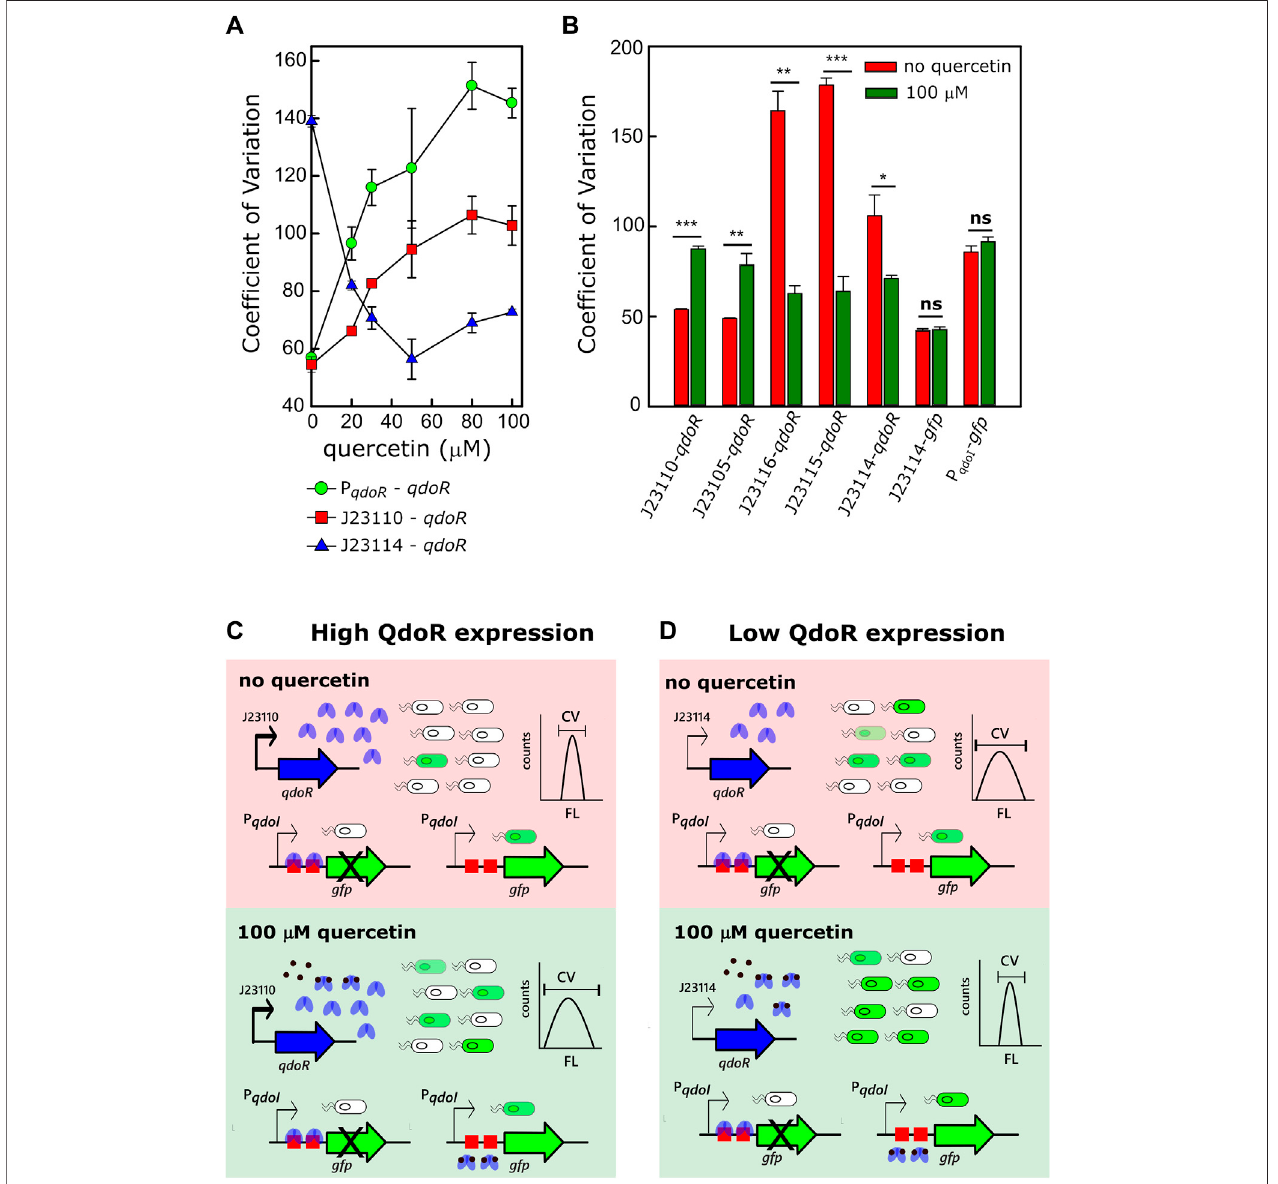
FIGURE3| TheQdoRexpression levelaffectstheamountofnoiseuponquercetin induction. (A) Thecoef fi cient ofvariation(CV)wascalculatedfromtheFLvalues measuredby fl owcytometry( λ ex (cid:2) 488 nm, λ em (cid:2) 530 nm).Threecircuitscontrolling gfp expressionwereinducedwithincreasingquercetinconcentrations:P qdoR - qdoR ( qdoR expression controlled by the minimal qdoR promoter) and J23110- qdoR and J23114- qdoR ( qdoR is expressed constitutively by the J23110 and J23114 promoters, respectively). The experiment was conducted with biological triplicates. (B) The CV of GFP expression in uninduced and induced E. coli cultures was correlatedwiththecircuitsdepictedin Figure2A ;allthesecircuitshad gfp asareporter.TheJ23114- gfp constructhastheJ23114constitutivepromotercontrollingthe expressionof gfp .TheP qdoI - gfp constructhasthenon-repressed qdoI promotercontrolling gfp expression.NotethatbothcircuitswithoutQdoRrepressiondonothave considerable variations on CV values upon the addition of quercetin. (C, D) Illustrative representation of the effect of QdoR expression on the CV values of GFP expression. Two states are considered in either high QdoR expression (J23110- qdoR ) or low QdoR expression (J23114- qdoR ): in light red, the uninduced repressed circuit, in light green, the circuit induced with 100 µM quercetin. J23110- qdoR and J23114- qdoR represent the regulatory modules. Below them, the possibilities of outputs to the reporter modules are depicted. White bacteria are completely repressed by QdoR with no GFP expression, while green bacteria have some GFP expression level that increases when quercetin is added. Note that the number of QdoR is high when J23110 controls the circuit, leading to derepression resistance when quercetin is added and an increase in noise (high CV amplitude in counts against FLplot). The cytometric pro fi les (countsvs. fl uorescence intensity) to each circuit at the uninduced and induced states are provided in Supplementary Figure S4 and Supplementary Table S3 . Statistical signi fi cance of the comparison for each circuit in uninduced and induced states is shown as p -values* ≤ 0.05, ** p -value ≤ 0.01, ** p -value ≤ 0.001 (independent two-sample t -test). The statistical comparisons between all circuits are provided in Supplementary Table S2 . The experiments were conducted with biological triplicates. After induction, the fl uorescence of each replicatewasmeasuredonceatspeci fi edtimes.Theexperimentswereconductedwithbiologicaltriplicates.After4 hofinduction,the fl uorescenceofeachreplicatewas measured once. The error bars represent the standard